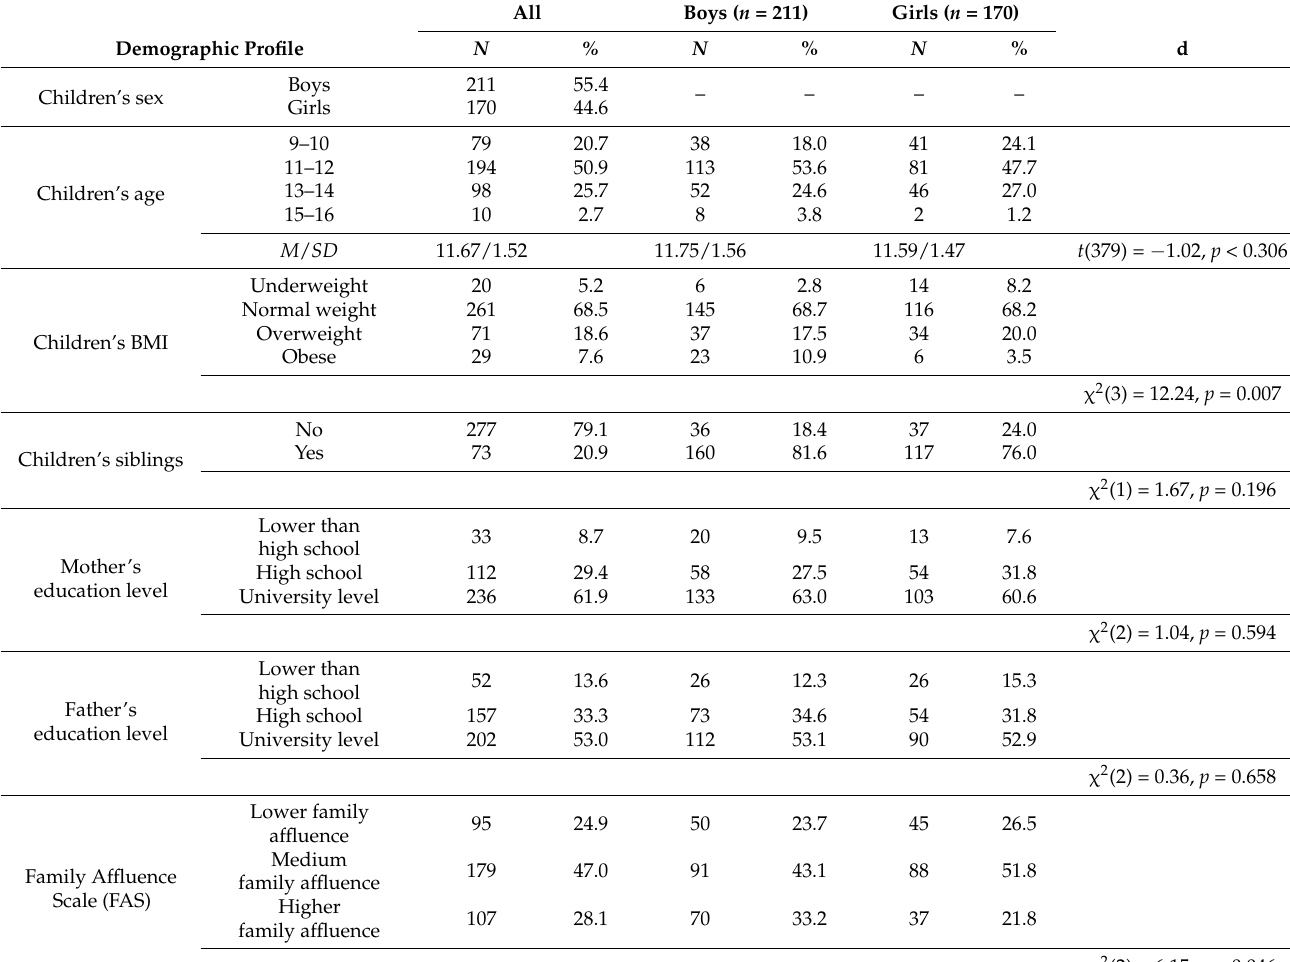
Table 1. Characteristics of study subjects by sex ( N = 381 1